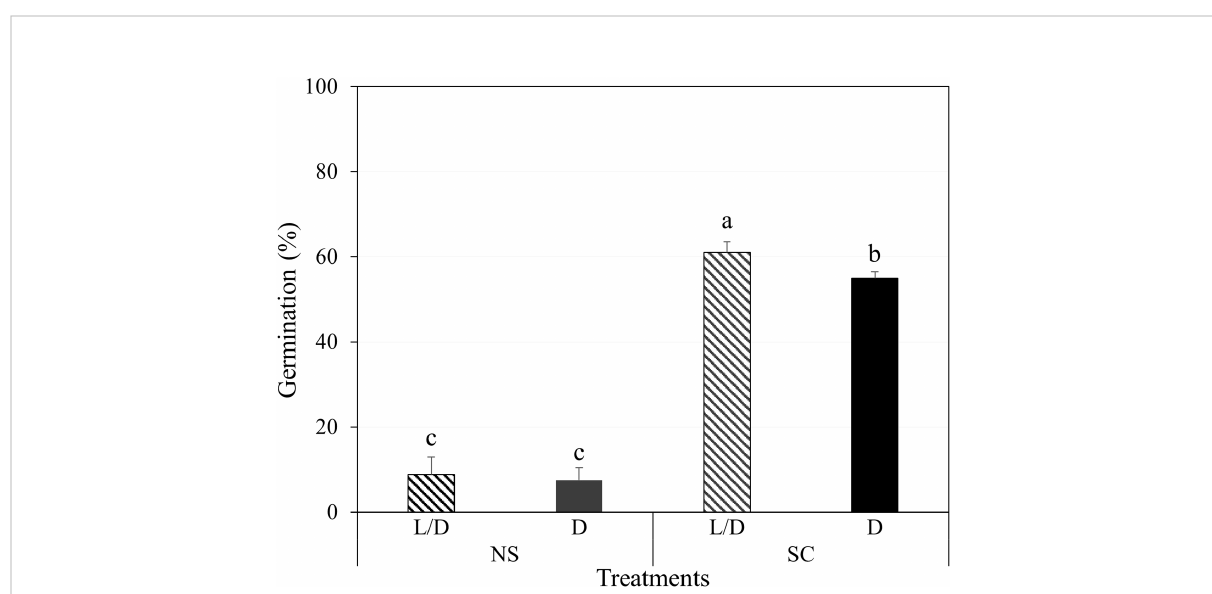
FIGURE 2 Initial germination of Amsonia elliptica seeds after 30 days. L/D, light/dark condition; D, dark condition; NS, non-scari fi ed; SC, scari fi ed. Bars represent standard error ( n = 4). Different lowercase letters indicate a signi fi cant difference tested by Duncan ’ s multiple range test (P <